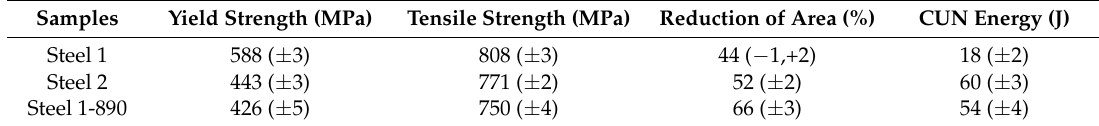
Table 2. Mechanical properties of samples.